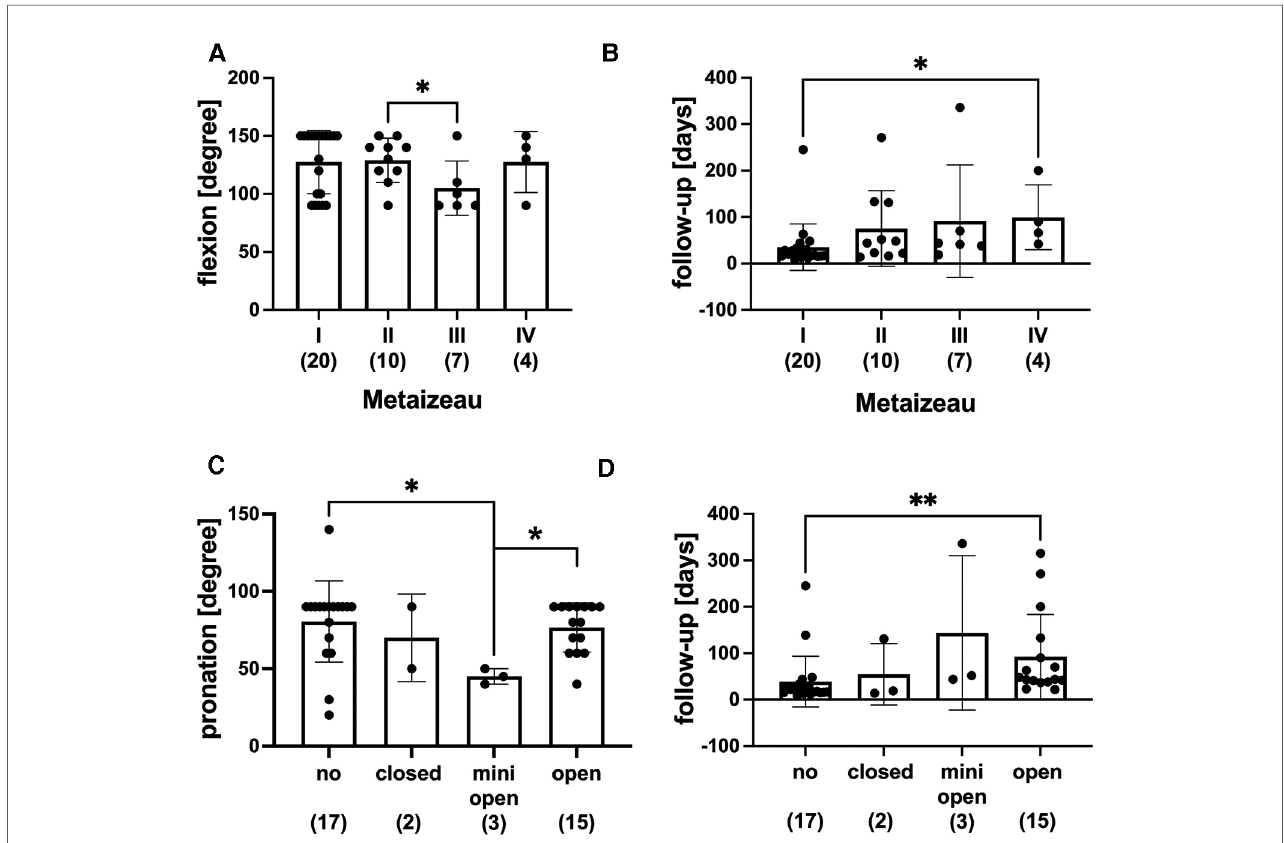
FIGURE 5 Range of motion after complete fracture consolidation. ( A ) Flexion of the elbow (degree) dependent on Metaizeau type. ( B ) Follow-up duration in days in respective Metaizeau types. ( C ) Pronation of the forearm (degree) depending on the reduction technique (no=without closed, mini=minimal open, open). ( D ) Follow-up duration in days in respective reduction techniques; graphical presentation mean±SD, * p <0.01, ** p <0.01, ( ) number of patients in respective